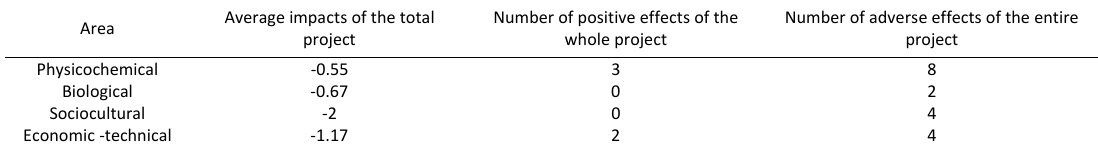
Table 2: Summary of the entire project for no implementation of the plan, operation phase Area